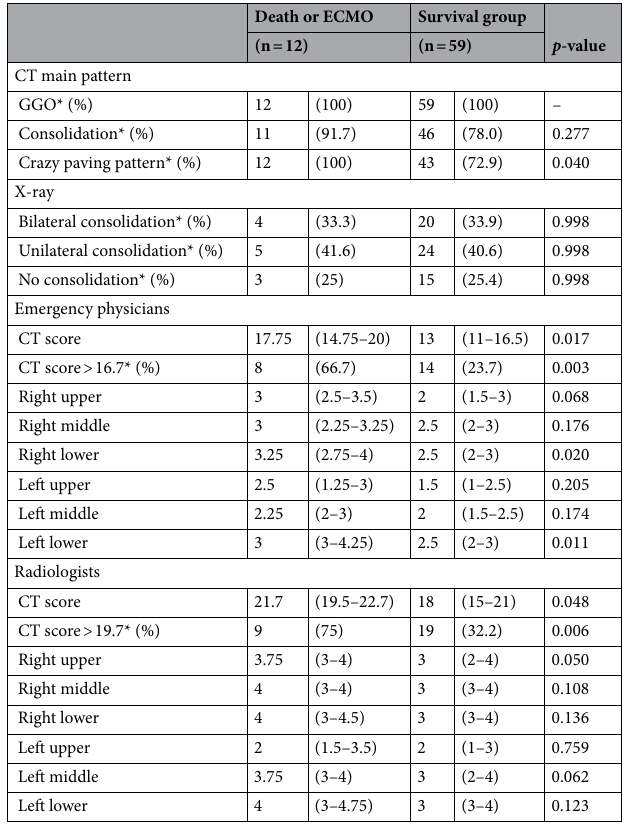
Table 2. Frequency of involvement of each section with related CT score and main patterns. *Frequency (%); Rest of data are presented as medians (IQR). CT computed tomography, GGO ground-glass opacity.